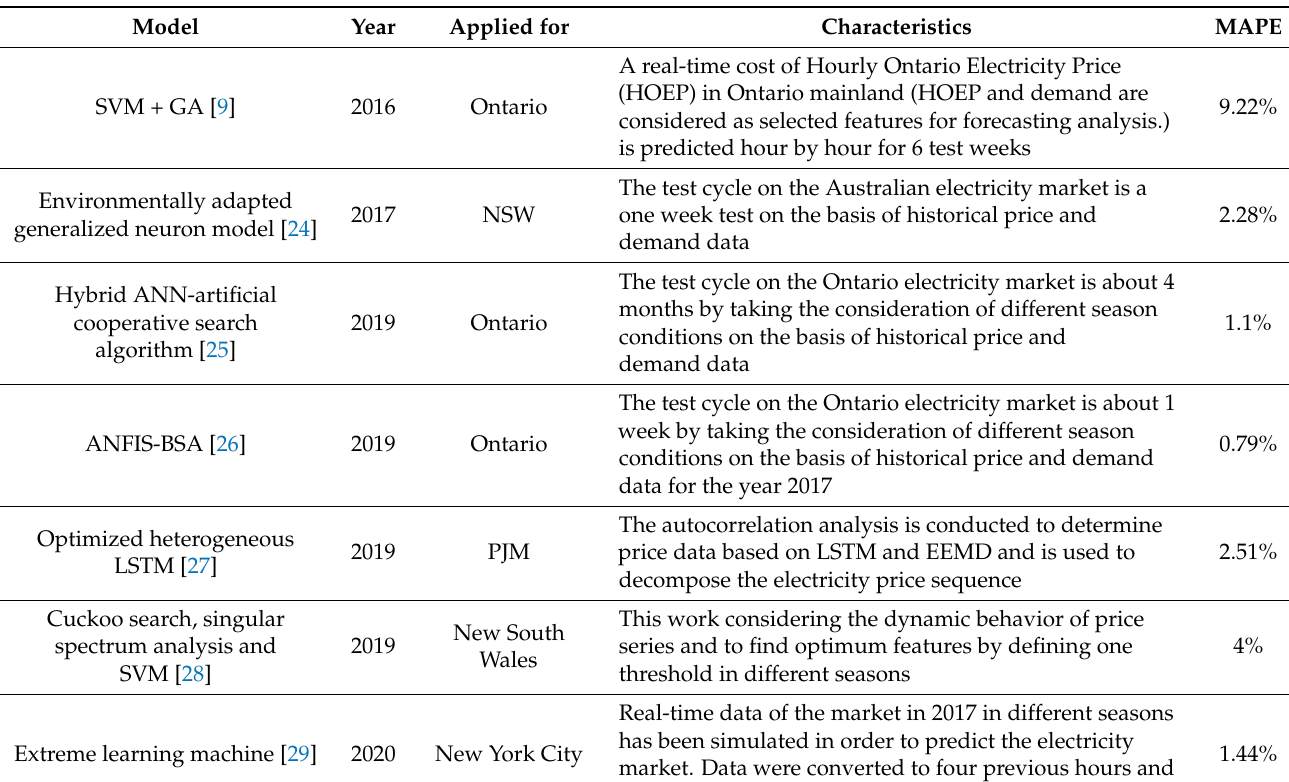
Table 1. Review of the developed artificial smart techniques implemented in literature for the prediction of EPF.